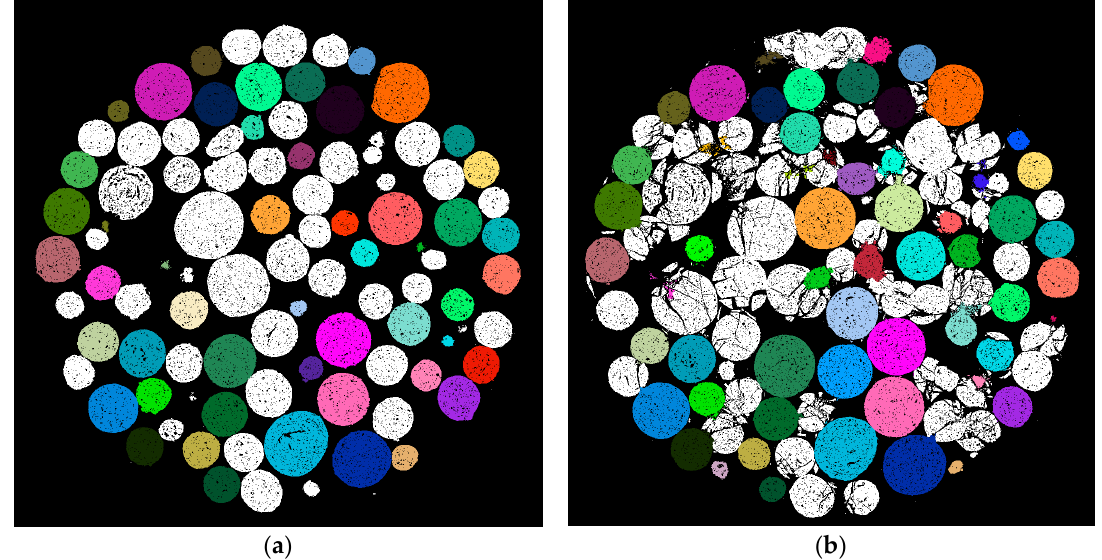
Figure 12. Slices with matched particles: ( a ) from image A ; ( b ) from image B .